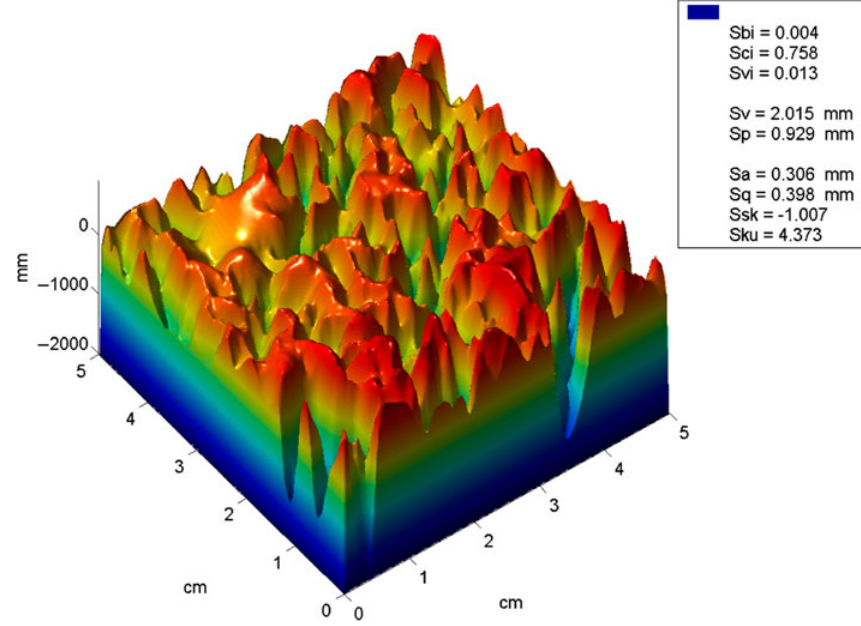
Fig. 2. Typical spatial image of scanned surface, and surface roughness parameters